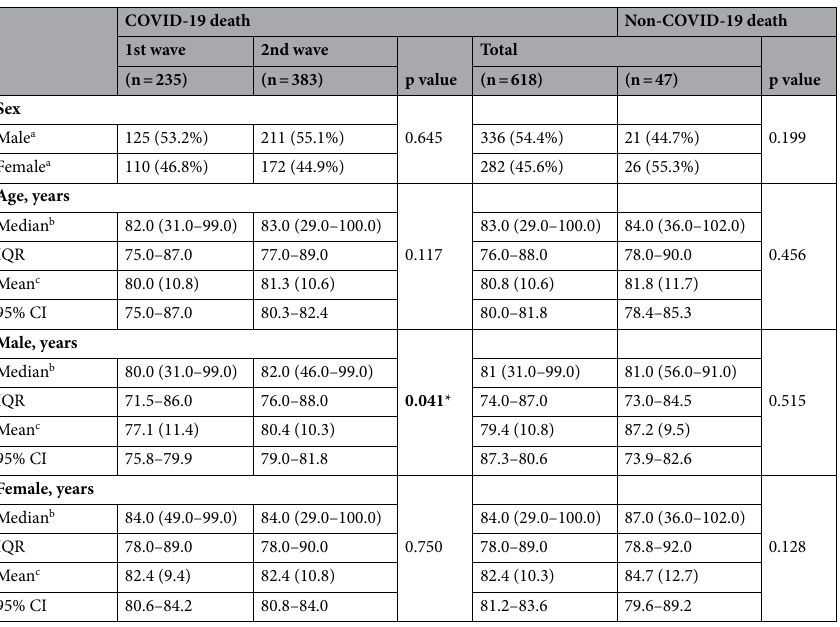
Table 1. Baseline characteristics of COVID-19 deaths and non-COVID-19 deaths (total N = 665; all unclear cases excluded). This table displays patient characteristics and demographics of COVID-19 and non- COVID-19 deaths. IQR interquartile range, CI confidence interval. a Number (%), b median (range), c mean (standard deviation). Statistically significant p values are highlighted in bold (*p < 0.05), the remaining values stayed